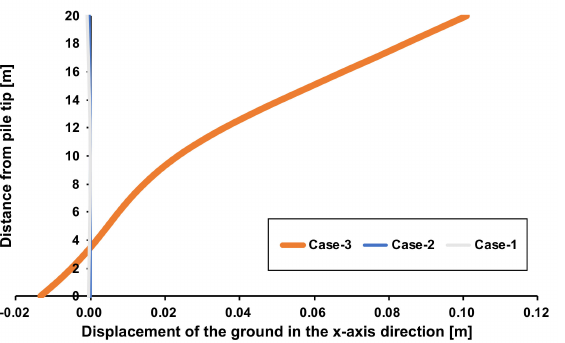
Figure 7. Comparison of displacements of ground in x -axis direction in Case-1, Case-2, and